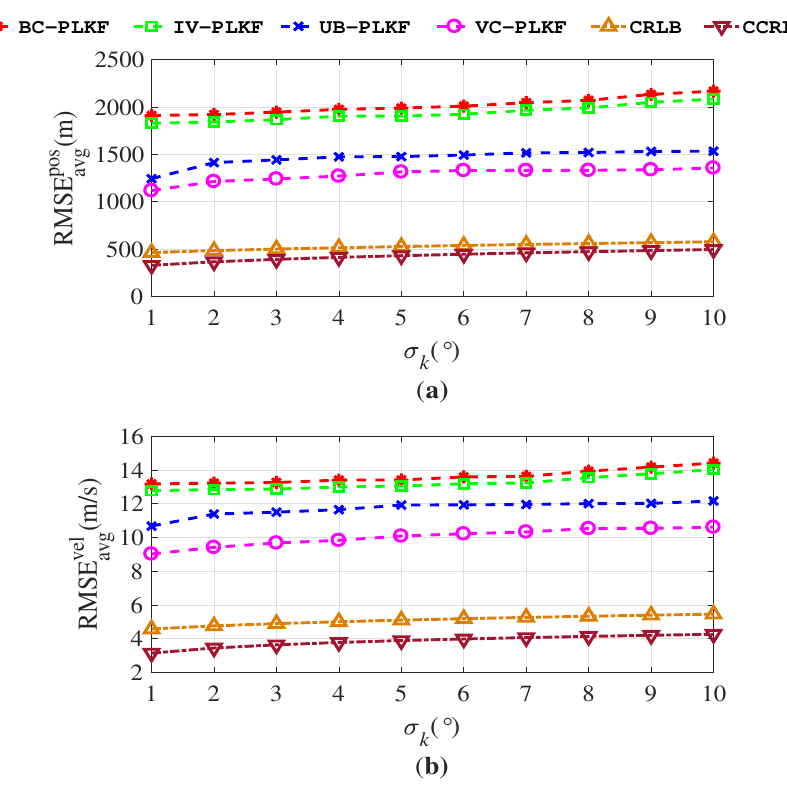
Figure 6. Time-averaged RMSEs for different algorithms in manoeuvring target tracking: ( a ) Time- averaged RMSEs for position; ( b ) Time-averaged RMSEs for velocity.